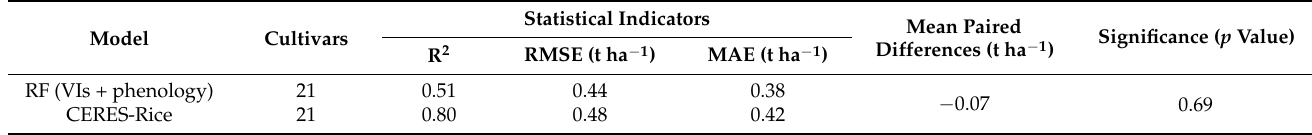
Table 7. Paired-samples t -tests for difference comparisons between the simulated values of the CERES-Rice model and the optimal RF model for 21 cultivars in